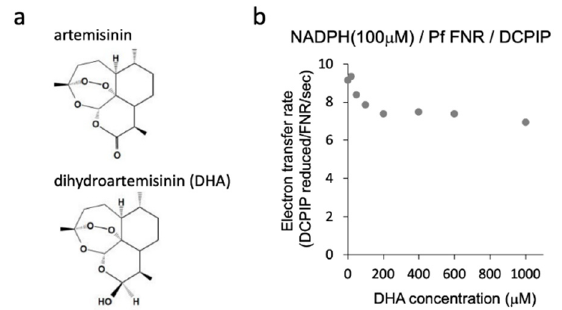
Figure 1. Structure of artemisinin and dihydroartemisinin (DHA) ( a ) and diaphorase activity of PfFNR with different concentrations of DHA ( b ). Diaphorase activity with DCPIP as an electron acceptor was measured in the absence and presence of DHA (at 20 µM-1 mM) under 100 µM of NADPH (non-saturating condition for PfFNR).